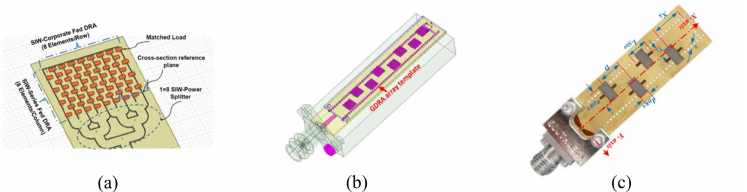
Figure 5. DRA array configurations: ( a ) SIW hybrid feeding [42]; ( b ) Artificial grid [44]; ( c ) Waveguide series-fed [45].